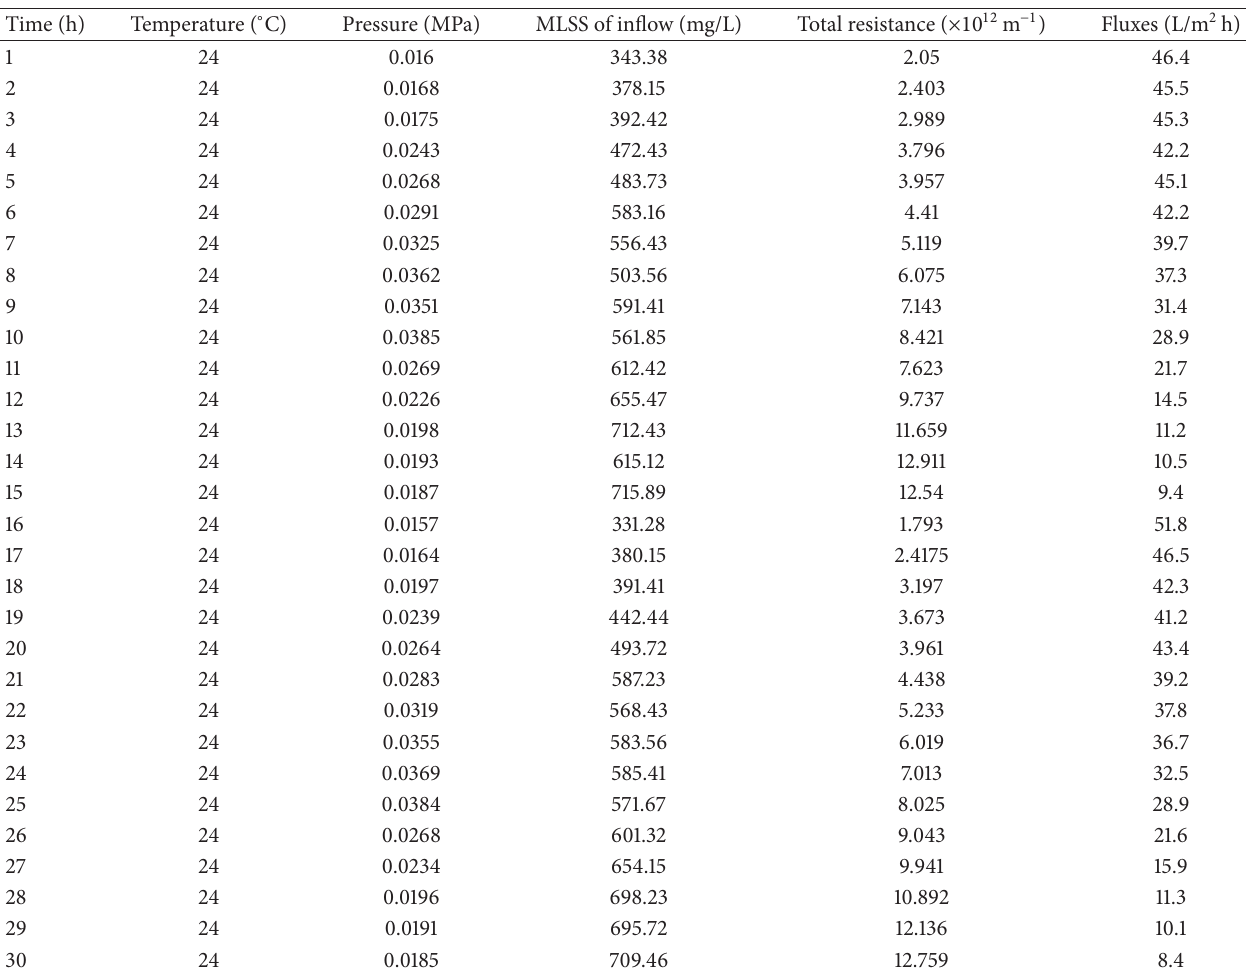
Table 1: Data of membrane flux, pressure, and so forth collected.